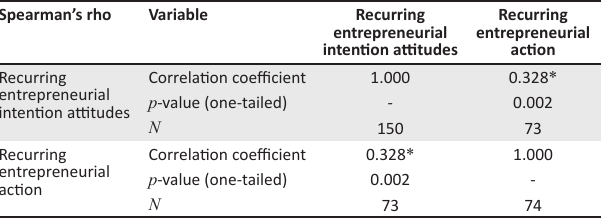
TABLE 3: Results of Spearman’s rank-order